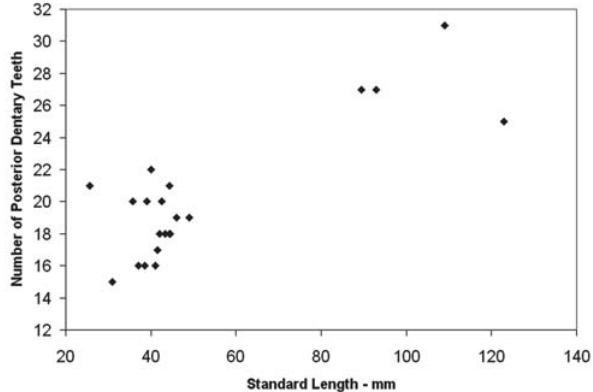
Fig. 3. Scatter plot of number of posterior dentary teeth on stan- dard length for all examined specimens of Galeocharax goeldii